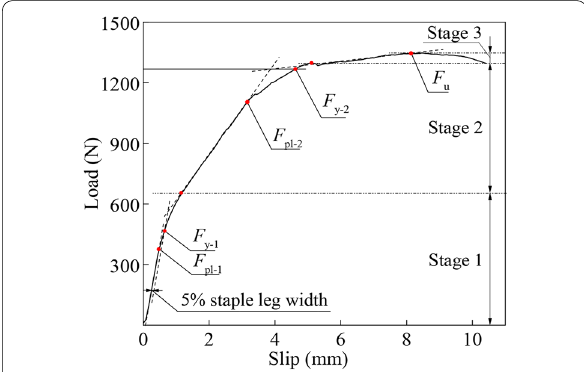
Fig. 10 A typical lateral load–slip curve of single-shear plywood-to-plywood single-staple connections subjected to a static lateral